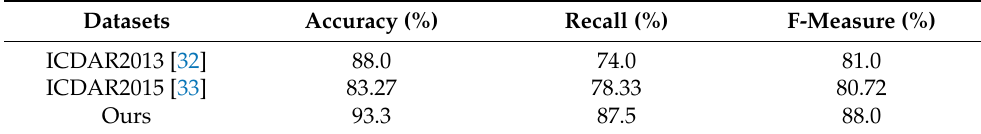
Table 4. Detection results in different datasets based on